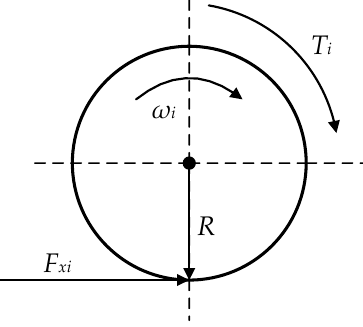
Figure 3. Tire rolling dynamic